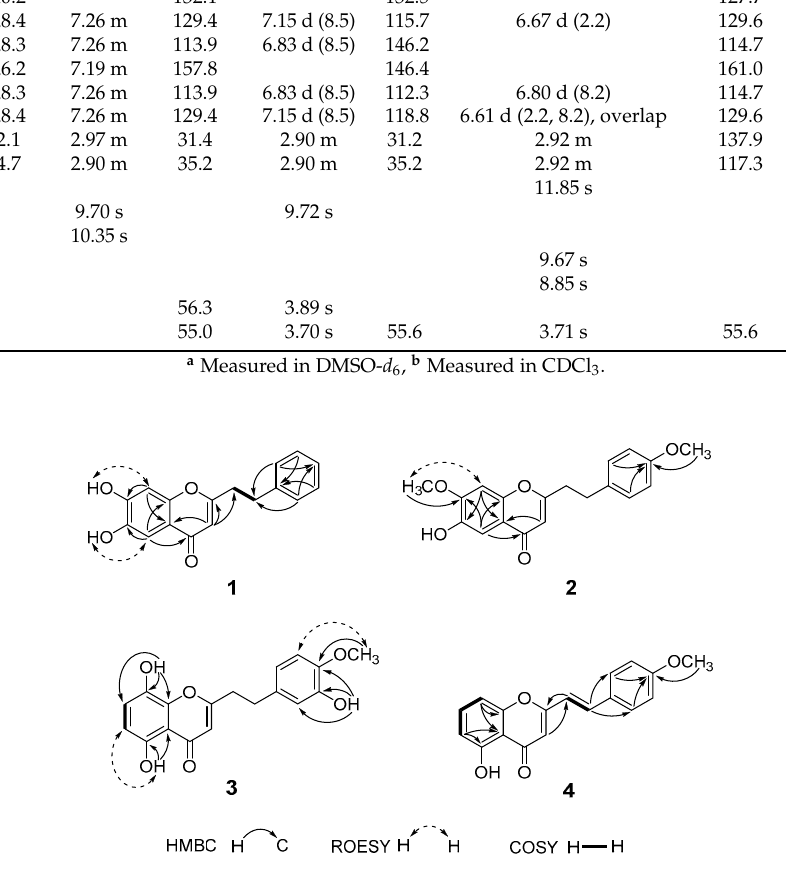
Figure 2. Key HMBC, ROESY, and 1 H- 1 H COSY correlations of compounds 1 – 4 .